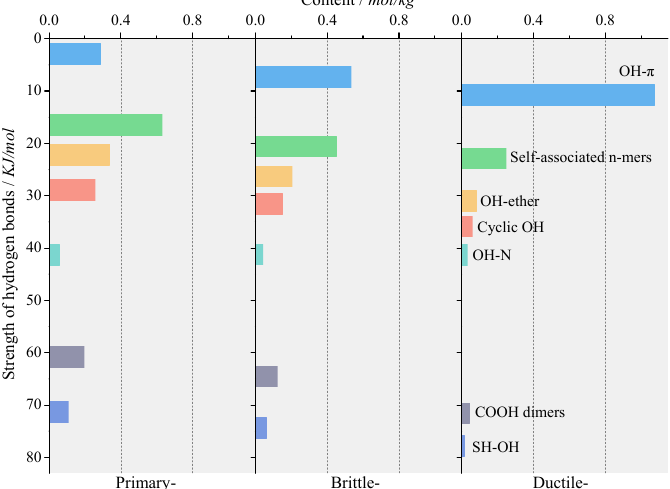
Figure 6. Distribution of HB strength in primary coal and the other two deformation sequences. Total and average enthalpy of HBs